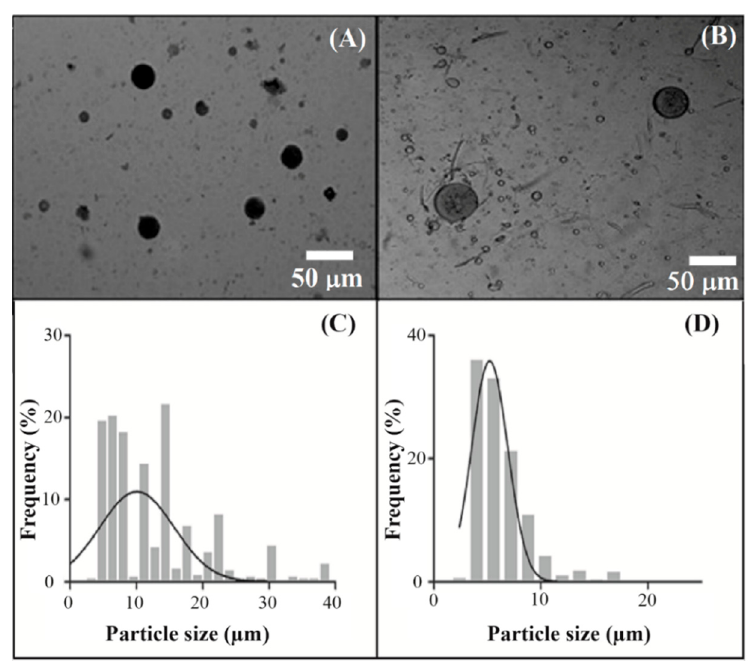
Figure 3. Optical microscopy ( A , B ) and particle size distribution ( C , D ) of XBM ( A , C , respectively) and XBM-Ca-F9 ( B , D , respectively), at a magnification of 10 χ with their respective Gaussian distribution (bold line, C , D ).